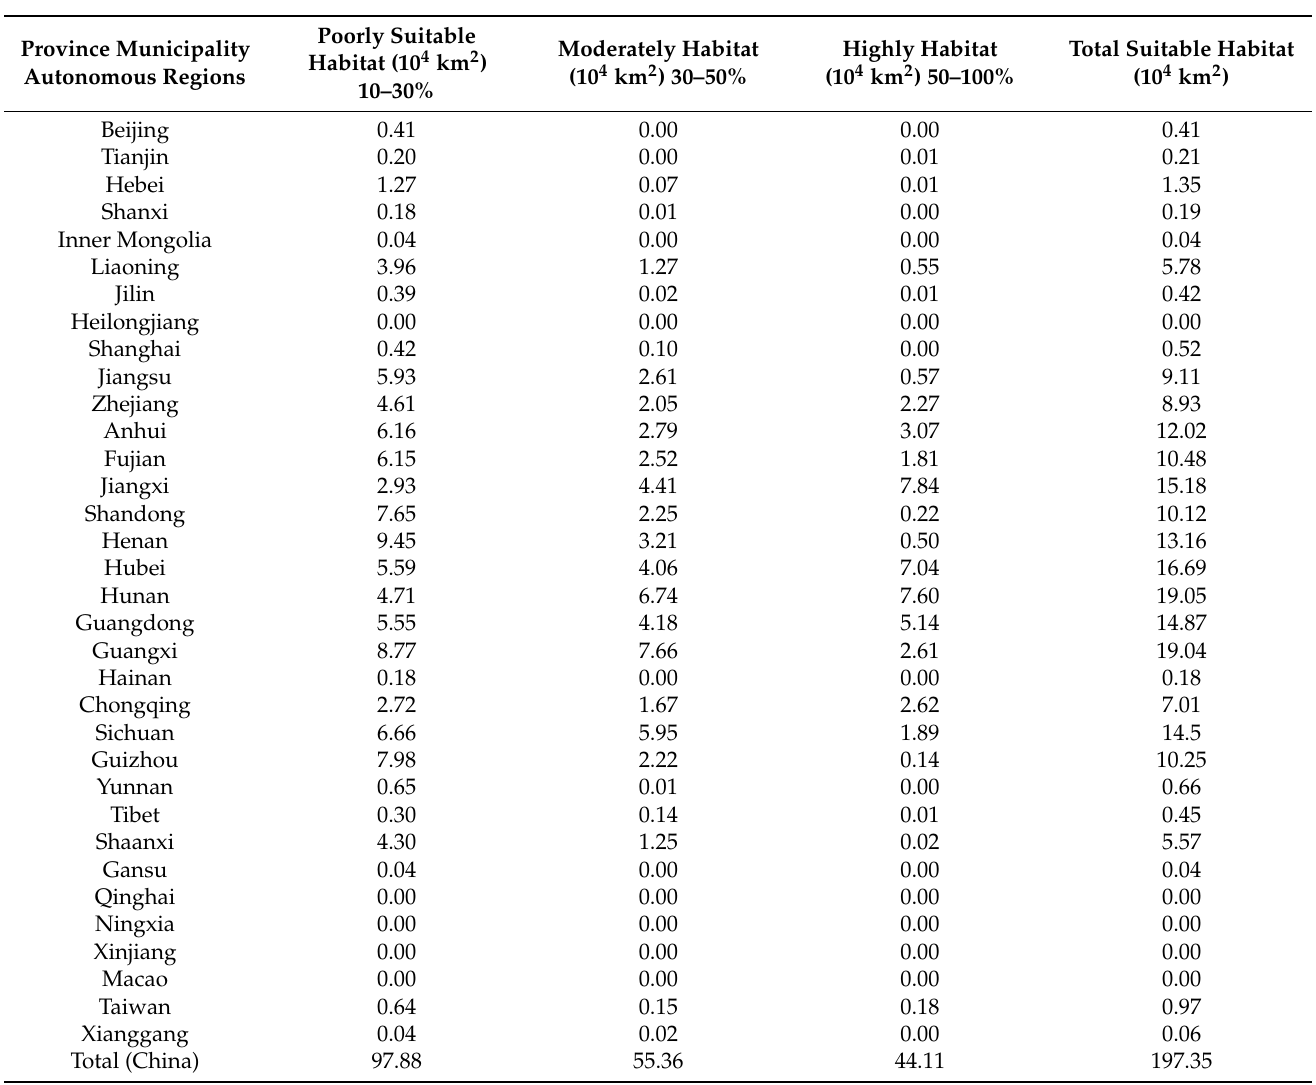
Table 2. The potential distribution areas for pine wilt disease under current climatic circumstances.